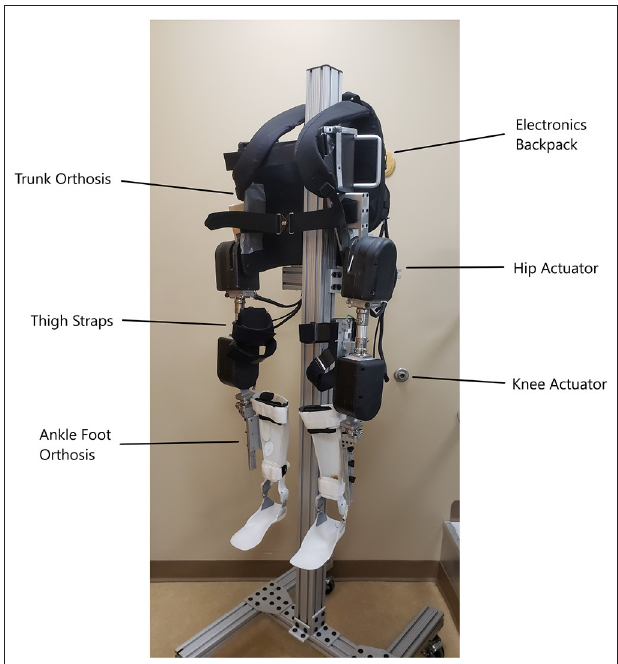
FIGURE 1 | The MAHNP exoskeleton.